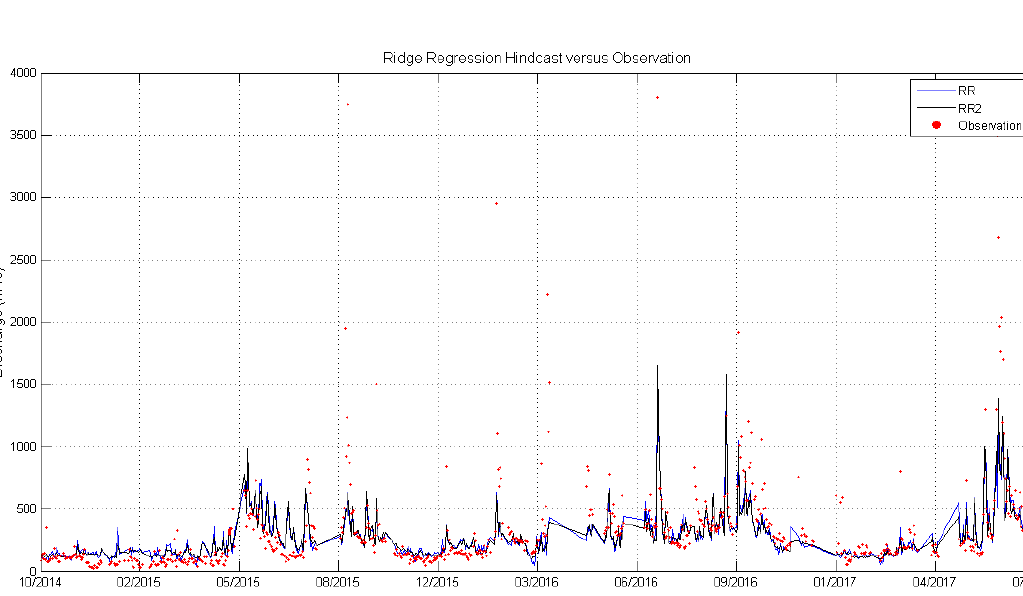
Table 10. RR2’s verification performance (continuous, monthly; n = 38).